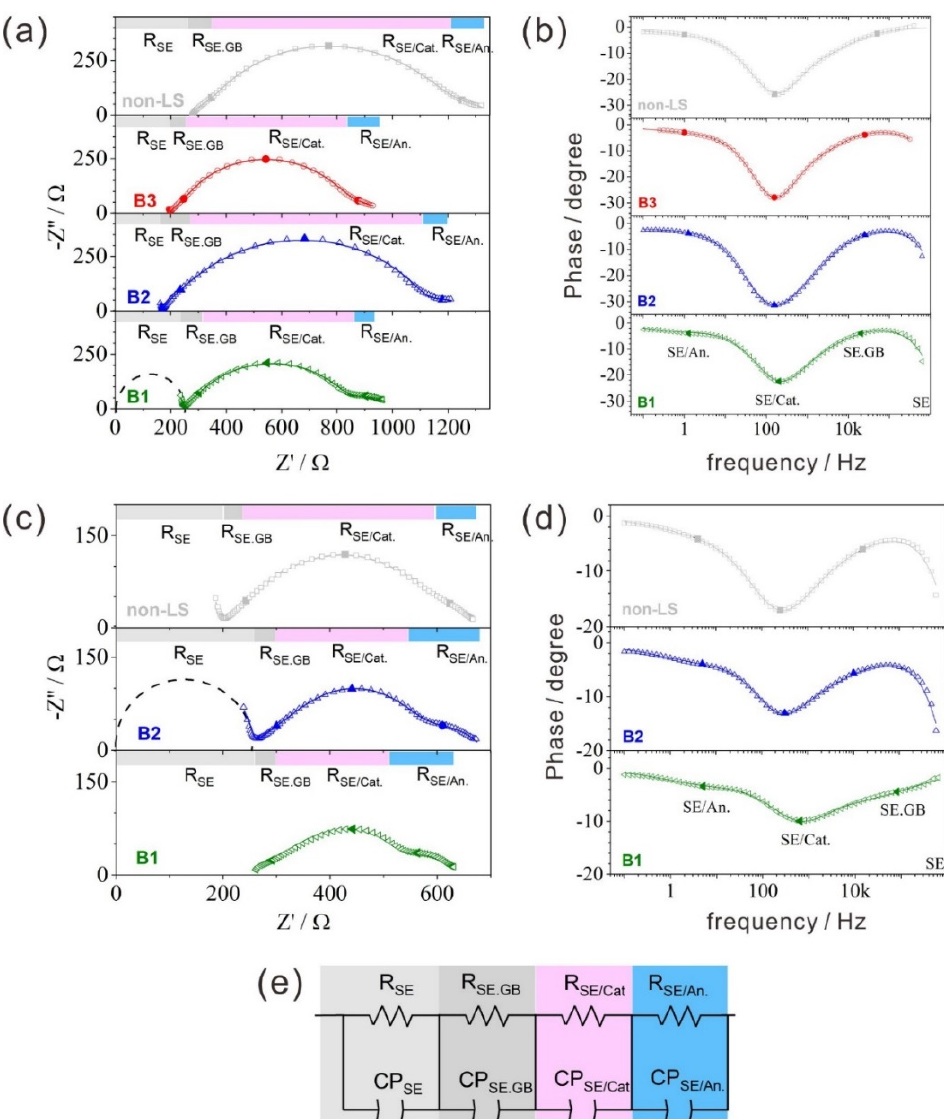
Figure 5. Nyquist and phase plots of the ASSBs using composite electrodes with 80Li 2 S ∙ 20P 2 S 5 solid electrolytes prepared via ( a , b ) simple mixture and ( c , d ) solution process at the 2nd charge cycle; experimental results (dots); fitting (line). Filled symbols are used to guide the frequency domains in both the Nyquist and Bode plots. ( e ) Equivalent circuit for impedance fitting. CP is the constant phase element used to simulate the capacitive behavior.